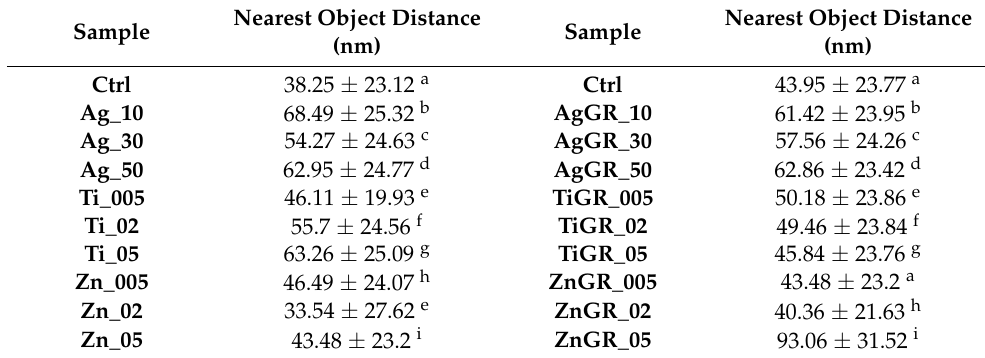
Table 6. Nearest object distance between fissures.